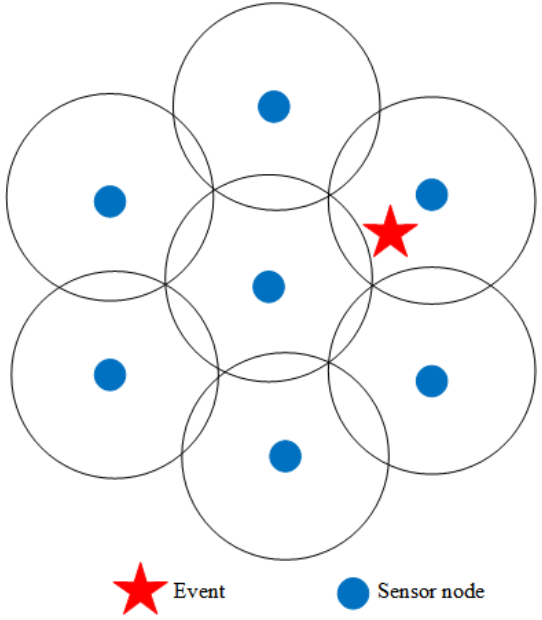
Figure 3. The diagram of